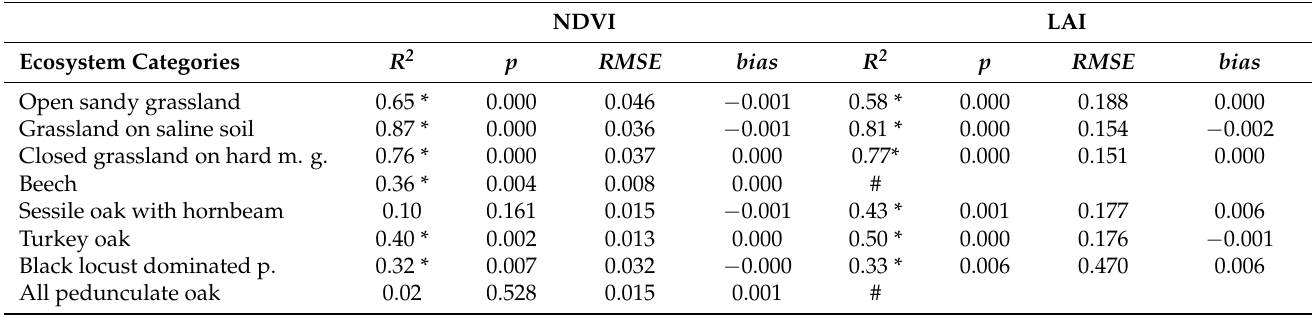
Table 4. The performance metrics of the cross-validation modeling NDVI and LAI in the selected late